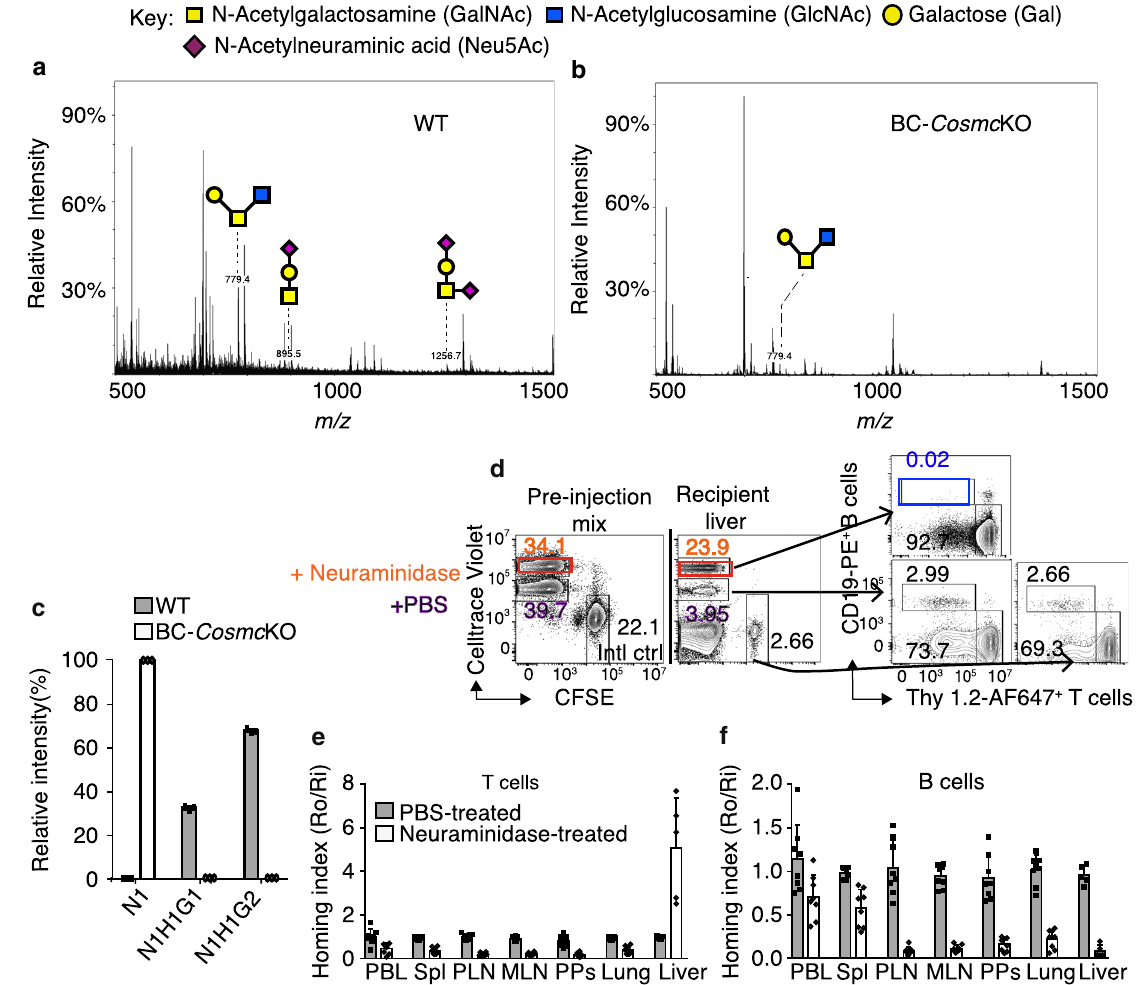
Fig. 4 Sialylation differentially regulates T and B cell traf fi cking. O-Glycans ( a , b ) were extracted from splenic B cells that were puri fi ed from WT ( a ) and BC- Cosmc KO ( b ) mice. The released glycans were subjected to mass spectrometric analysis. The peaks with annotated glycan structures are listed. Other peaks are background noise, not matching to any glycan mass. c IgG2b hinge-region O-glycosylation characterization in WT and BC- Cosmc KO serum. The O-glycan distribution of the IgG2b hinge-region tryptic peptide (K)LEPSGPISTINPCPPCK. Thr104 (UniProt annotation) was identi fi ed to be O-glycosylated. Glycan compositions are indicated with H — hexose; N — N-acetylhexosamine; G — N-glycolylneuraminic acid. d – f Single cell suspension of splenocytes from WT mice were labeled with CellTrace Violet or CFSE and treated with neuraminidase. The preparation of the splenocytes was co-injected into recipient mice ( n = 8, except for n = 5 for liver). Lymphoid tissues were harvested at 1 h after transfer. d Representative fl ow cytometric dot plots show input cells ratio before injection and after transfer. Neuraminidase in orange rectangle, and numbers in orange (percentage of total input) indicated donor cells treated with Neuraminidase. PBS in purple numbers (percentage of total input) indicated donor cells treated with PBS. Blue rectangle and numbers indicated neuraminidase-treated and transferred B cell population that recovered from the indicated tissue of recipients. e , f Homing indices were calculated based on the percentage of homed T and B cells. The homing index was calculated as the [percentage of dye + CD19 + B cells or Thy1.2 + T cells] tissue / [percentage of internal control CFSE + B cells or T cells] tissue ratio to the input ratio. Each symbol (black square and open circle for WT and BC- Cosmc KO, respectively) represents an individual mouse. Data are presented as average ±SD of each genotype with each individual value plotted. Source data are provided as a Source Data fi